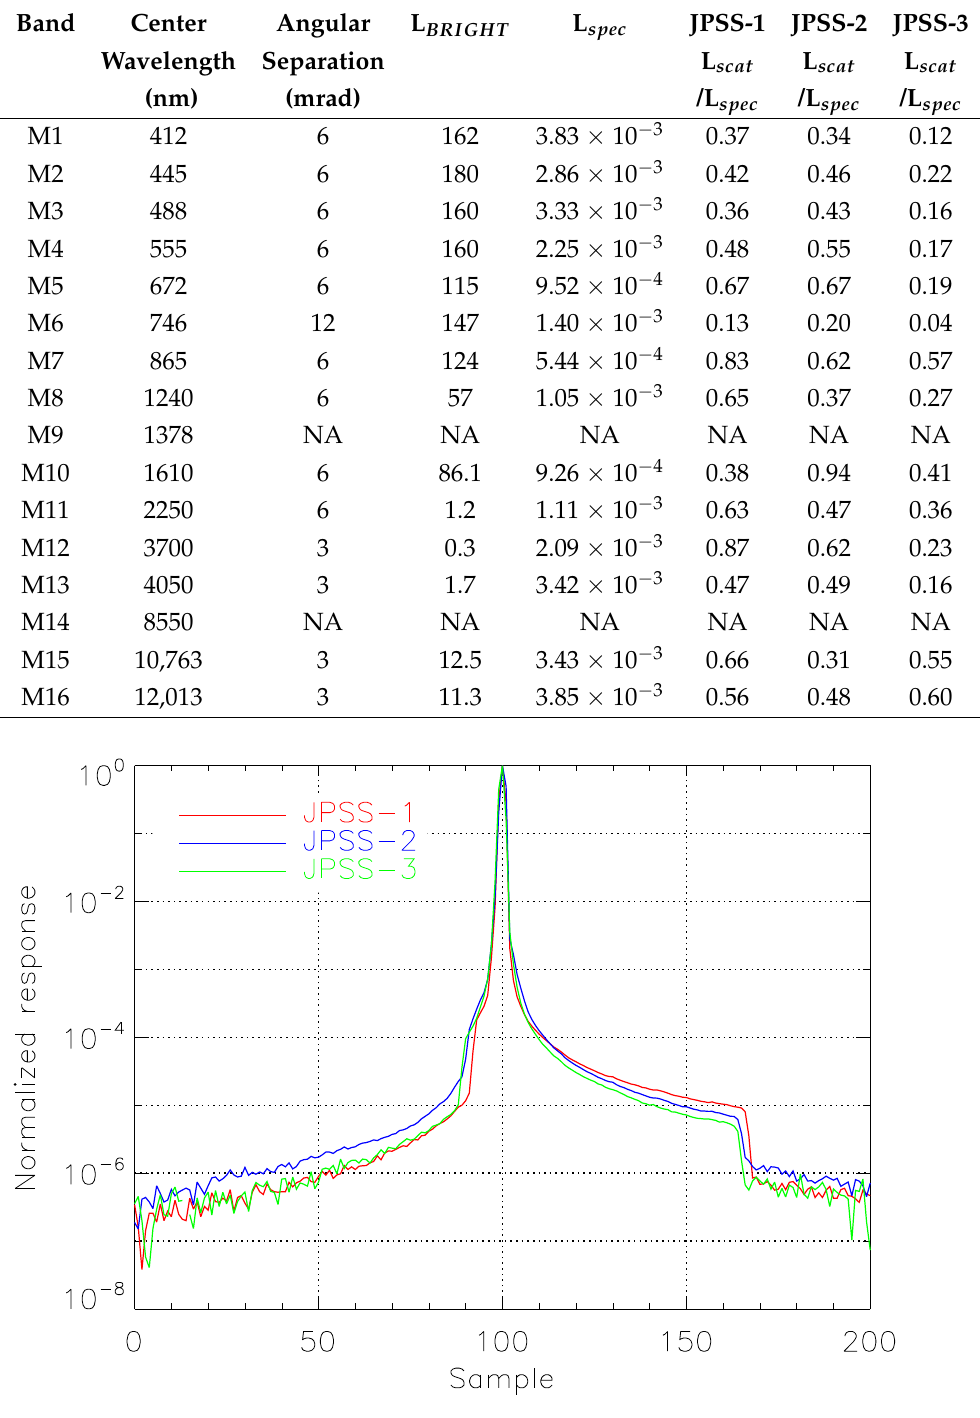
Table 9. JPSS-3 VIIRS NFR performance relative to the sensor specification [10].